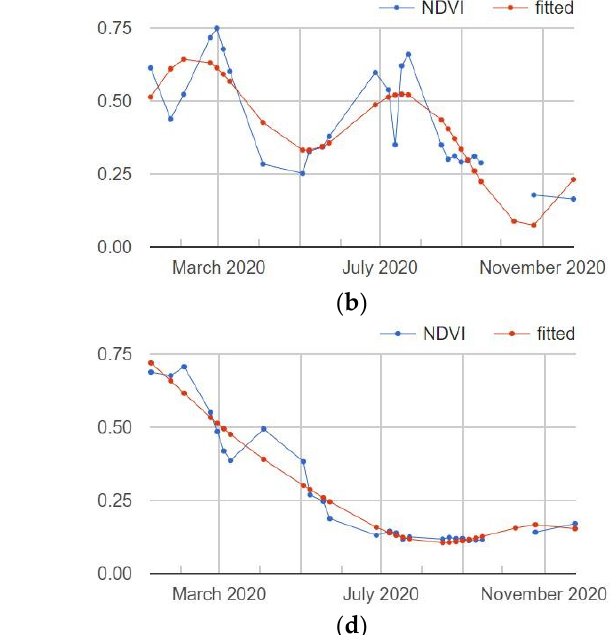
Figure 3. Reference data collection tool using NDVI time series inspector developed in GEE with S2 NDVI TS and harmonic fit based on GEE’s implementation example [60]. Per click time-series infor- mation allowed for categorizing annual crops into ” winter ” , ” spring ” , ” summer ” and “ double crop- ping ” . Based on Copernicus Sentinel data (2020).